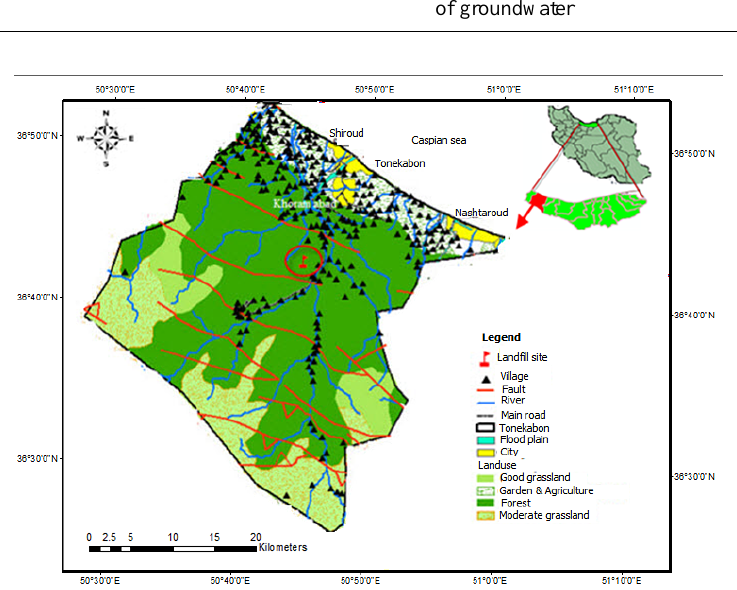
Figure 1. Location of Tonekabon in Mazandaran province,